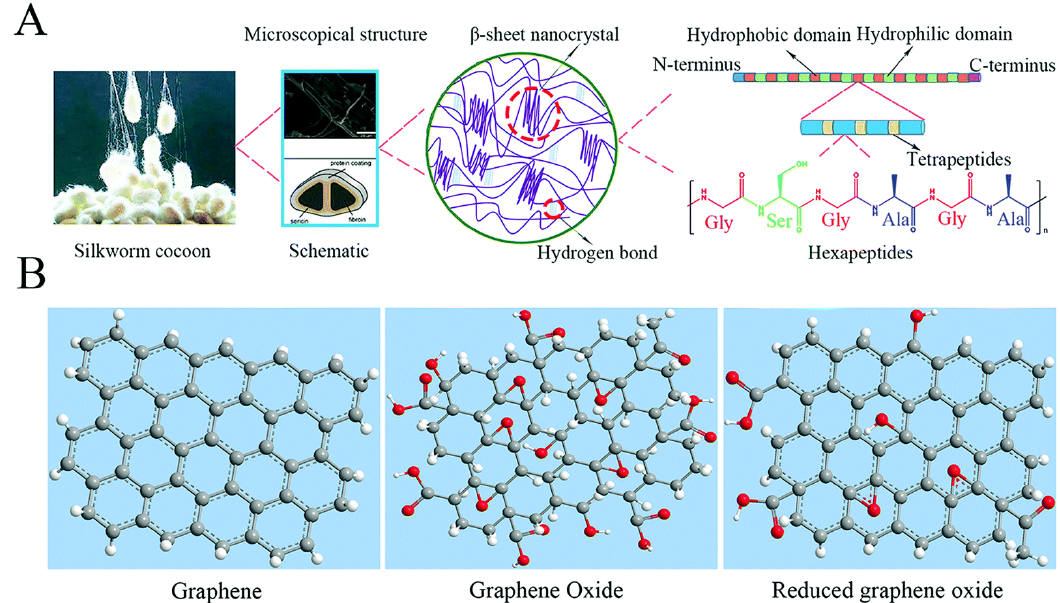
Figure 1. The structures of SF and graphene-based nanomaterial building blocks: ( A ) the hierarchical structure of SF; ( B ) the structures of GBNs. Reproduced with permission from [15].